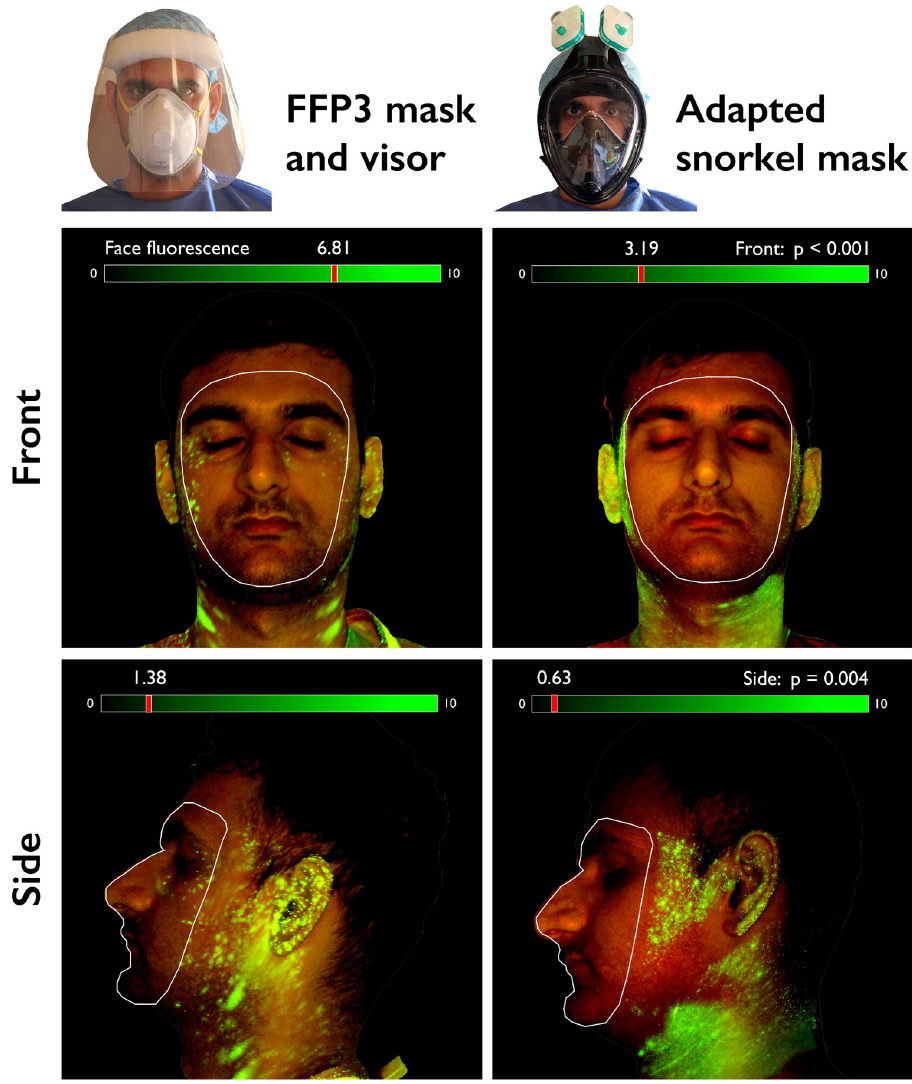
Fig 2. Front and side face UV-light images (with blue filter applied) following spraying of fluorescence oil and doffing of personal protective equipment. The snorkel mask provides better protection against fluorescence droplets, compared to a combination of FFP3 masks and face visor. Fluorescence scale in Corrected Total Fluorescence units (x10 8 ) (see also S1 Fig 2 in S1 Appendix for other comparisons).